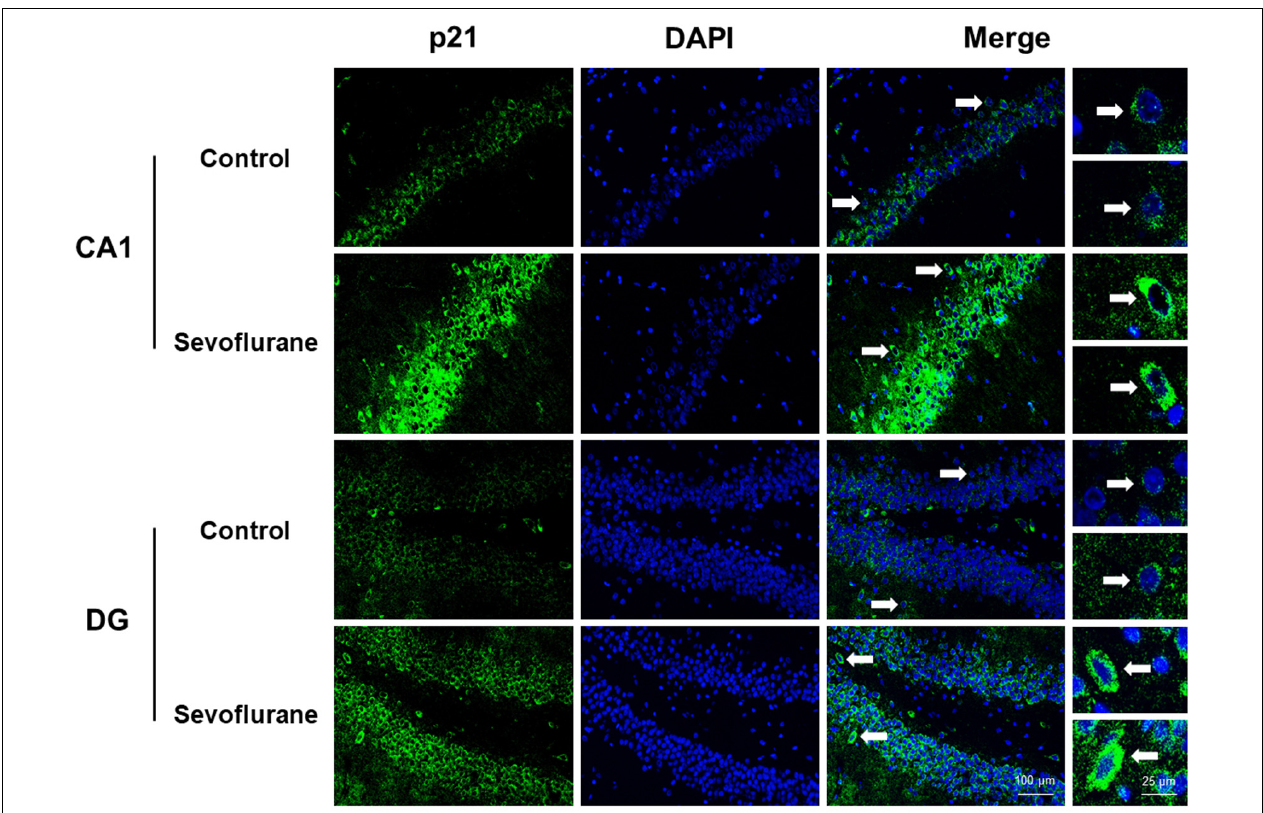
FIGURE 9 | Immunofluorescent staining of hippocampal Cdkn1a in the CA1 region and DG region. Immunofluorescence images show RelA (FITC, green) and DAPI (blue) counterstain. In the control condition, the staining intensity of RelA in the cytosol of the pyramidal cell layer, CA1 region and the cytosol of the granular cell layer, DG region are weak. Six hours after exposure, the staining intensity of RelA in the cytosol of cells in both the CA1 region and the DG region is obviously increased. Arrows point to the typical RelA distribution, which are provided as high magnification images. Magnification 400 × , scale bar 100 and 25 µ